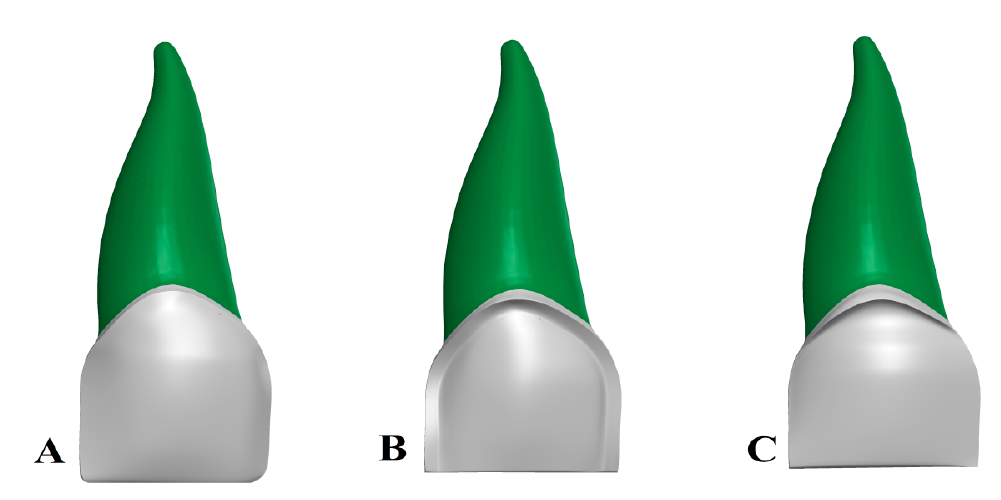
Figure 2. ( A ) Non-preparation design, ( B ) conventional preparation design, and ( C ) proposed preparation